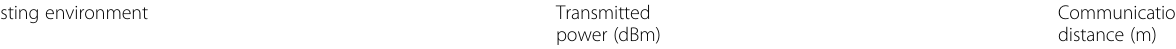
Table 1 The range of communication under different wireless transmission powers Testing